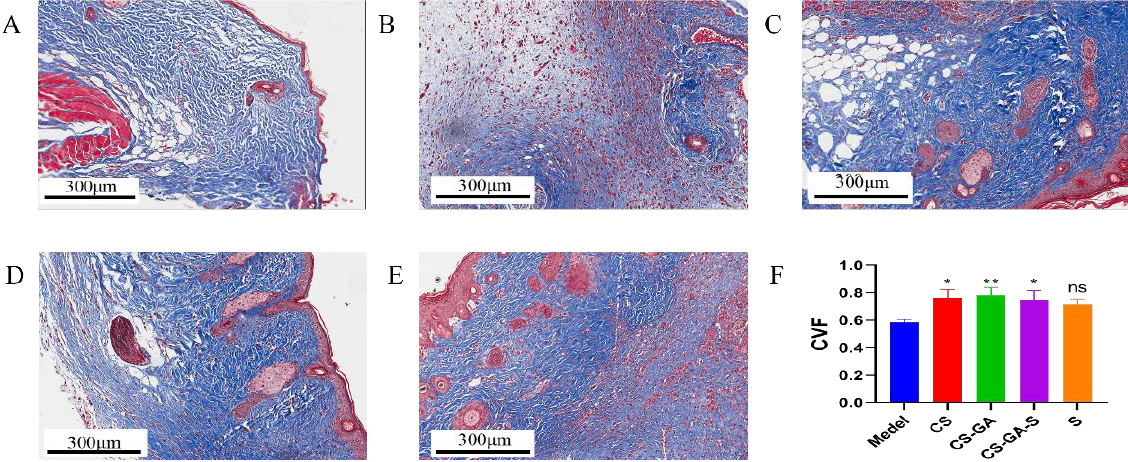
Figure 11. Masson staining microscopic images of skin. ( A ) Model group, ( B ) CS group, ( C ) hydrogel group, ( D ) scolopin2 group, and ( E ) CS-GA-S group. ( F ) The collagen volume fraction (CVF). Scale bar: 300 μm. ns represents no significance, * represents p < 0.05, ** represents p < 0.005.